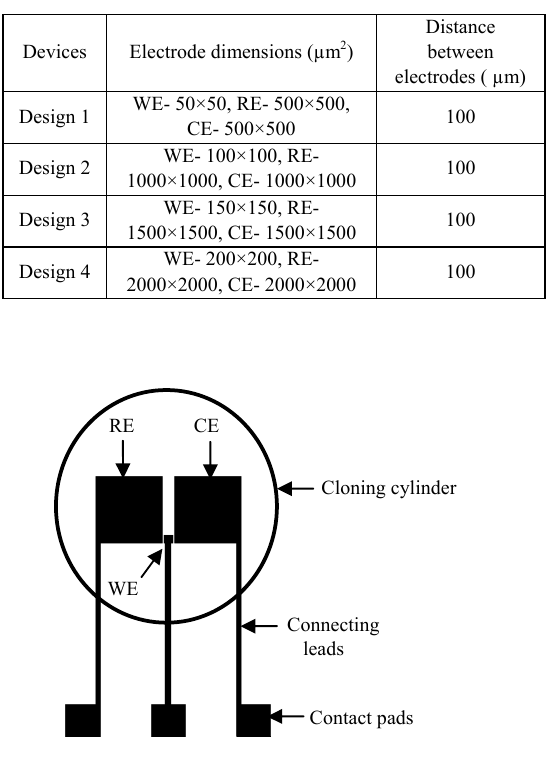
Fig. 1: Schematic representation of three-electrode based ECIS devices.